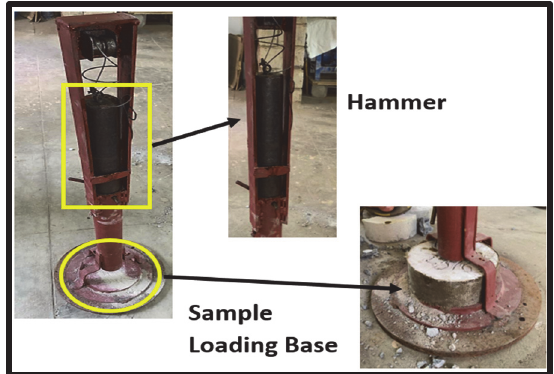
Figure 4: Impact test